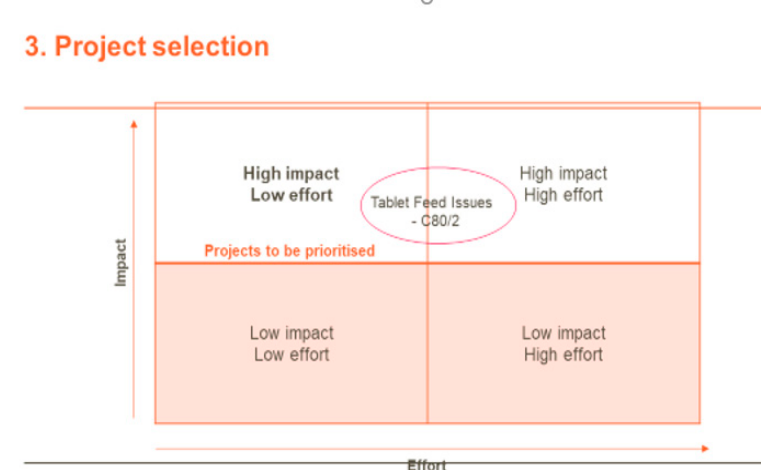
Figure 6. Project Selection Matrix with Impact on the y-axis and Effort on the x-axis. Tablet feed issues were deemed to be a high impact project with a mix of low and high effort resources required. The problem statement was defined and measured in more